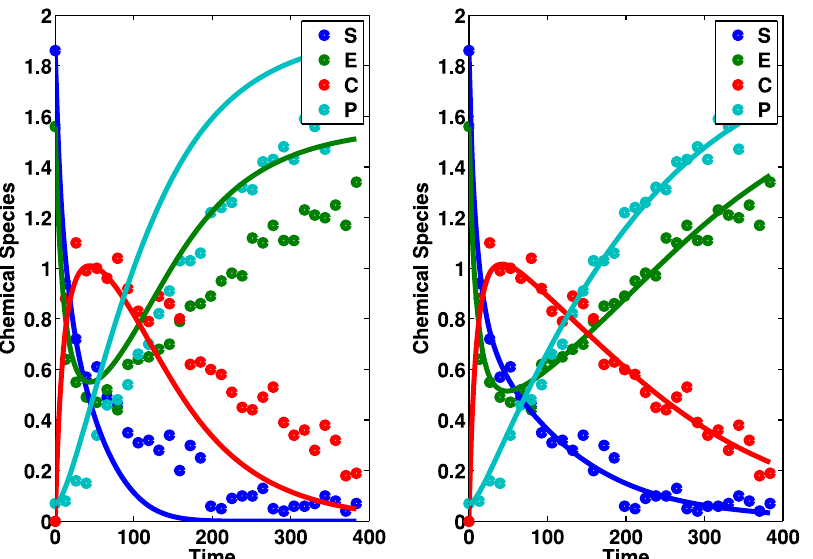
Figure 3. Input and Output time course data for the irreversible Michaelis–Menten reaction mechanism. The reaction mechanism describes interactions between four chemical species. Open circles represent the input time course data. Solid lines represent the output time course data. We produced the output using the Empirical (left plot) and the Akaike (right plot) information criteria. MIKANA cannot reconstruct the Michaelis–Menten reaction mechanism and its dynamical behavior using the Empirical information criterion. However, the reconstruction is excellent using the Akaike information criterion.